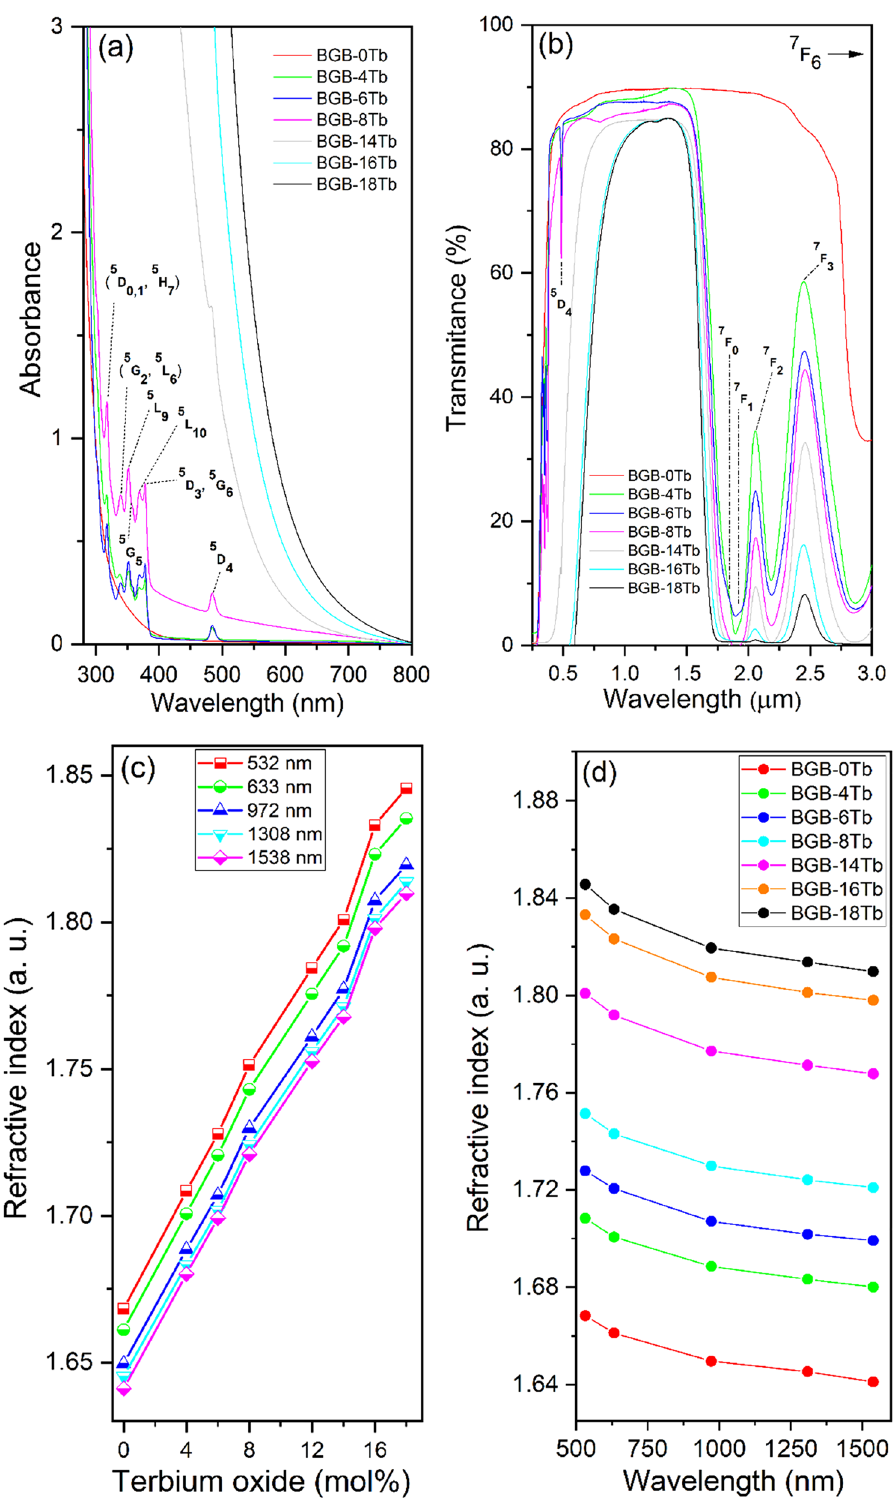
Figure 6. ( a ) UV–Vis–NIR optical absorption, ( b ) transmission spectra, ( c ) refractive indices as a function of Tb 4 O 7 content, at different wavelengths, and ( d ) refractive indices for BGB- x Tb glasses (0 ≤ x ≤ 18), as a function of